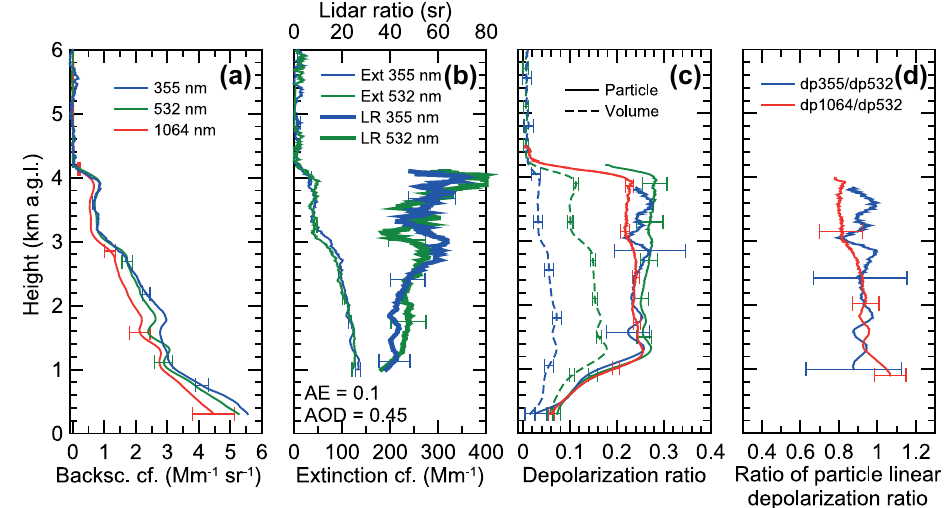
Figure 9. 3h mean profiles of (a) the particle backscatter coefficient at three wavelengths, (b) the extinction coefficient and lidar ratio at two wavelengths, (c) the volume and particle linear depolarization ratio at three wavelengths, and (d) the ratio of the 355 to 532nm and 1064 to 532nm particle depolarization ratio. The lidar observation was performed on 20–21 June 2014, 23:10–02:10UTC. The vertical signal smoothing window length is 200m (backscatter coefficient, depolarization ratio) and 750m (extinction coefficient, lidar ratio). Error bars indicate the retrieval uncertainty.